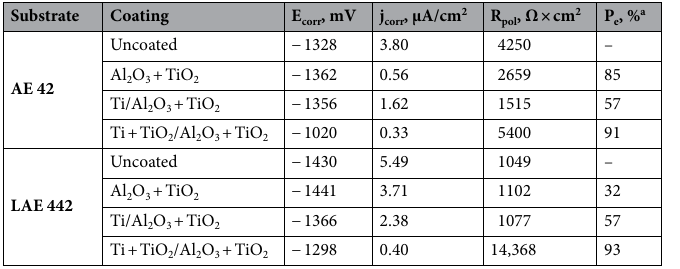
Table 3. Potentiodynamic polarisation parameters for samples in 0.05 M NaCl solution. a P e —corrosion